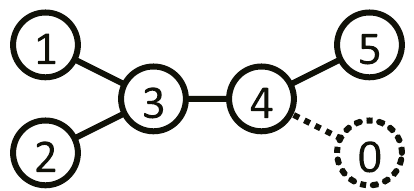
Figure 3 . The Dynkin diagram of the D 5